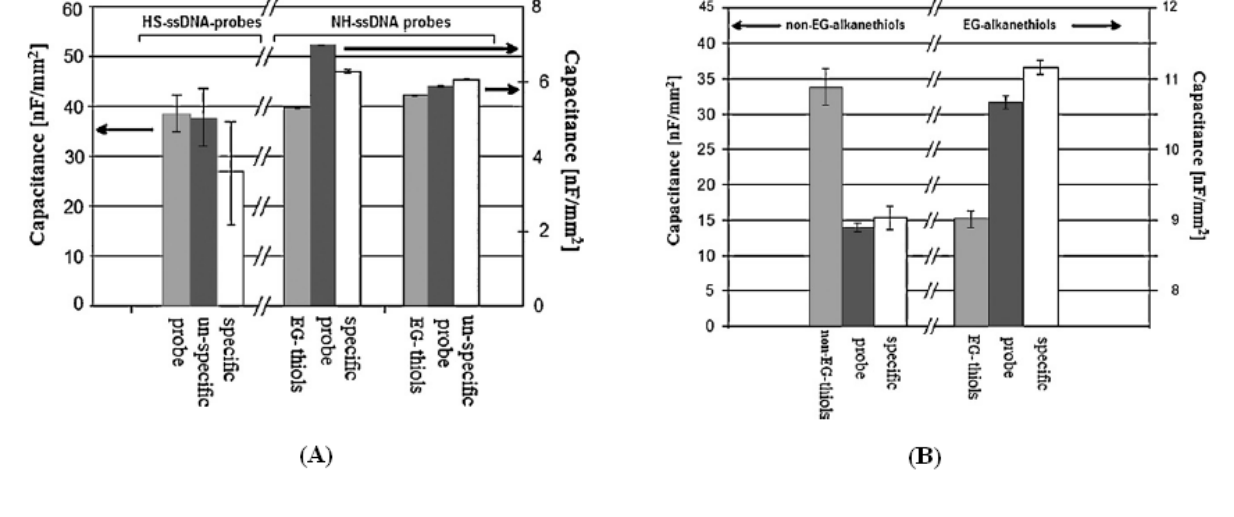
Figure 4. (A) Direct comparison between detection performances of ss-DNA probes directly immobilized onto gold and ss-DNA probes immobilized onto ethylene-glycol mono-layer. (B) Direct comparison between detection performances of antibody probes immobilized onto mono-layers without or with ethylene-glycol function (both figures are reprinted from reference [26] with permission from Elsevier, copyright